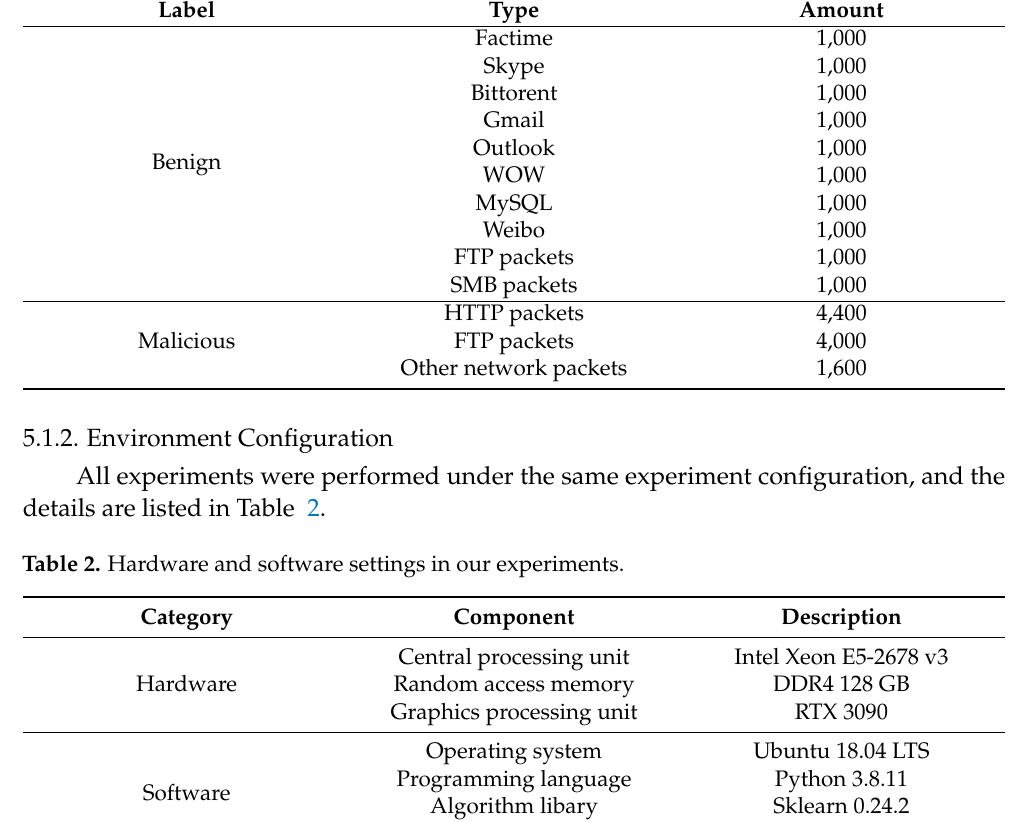
Table 1. Details of dataset used in this paper. Label